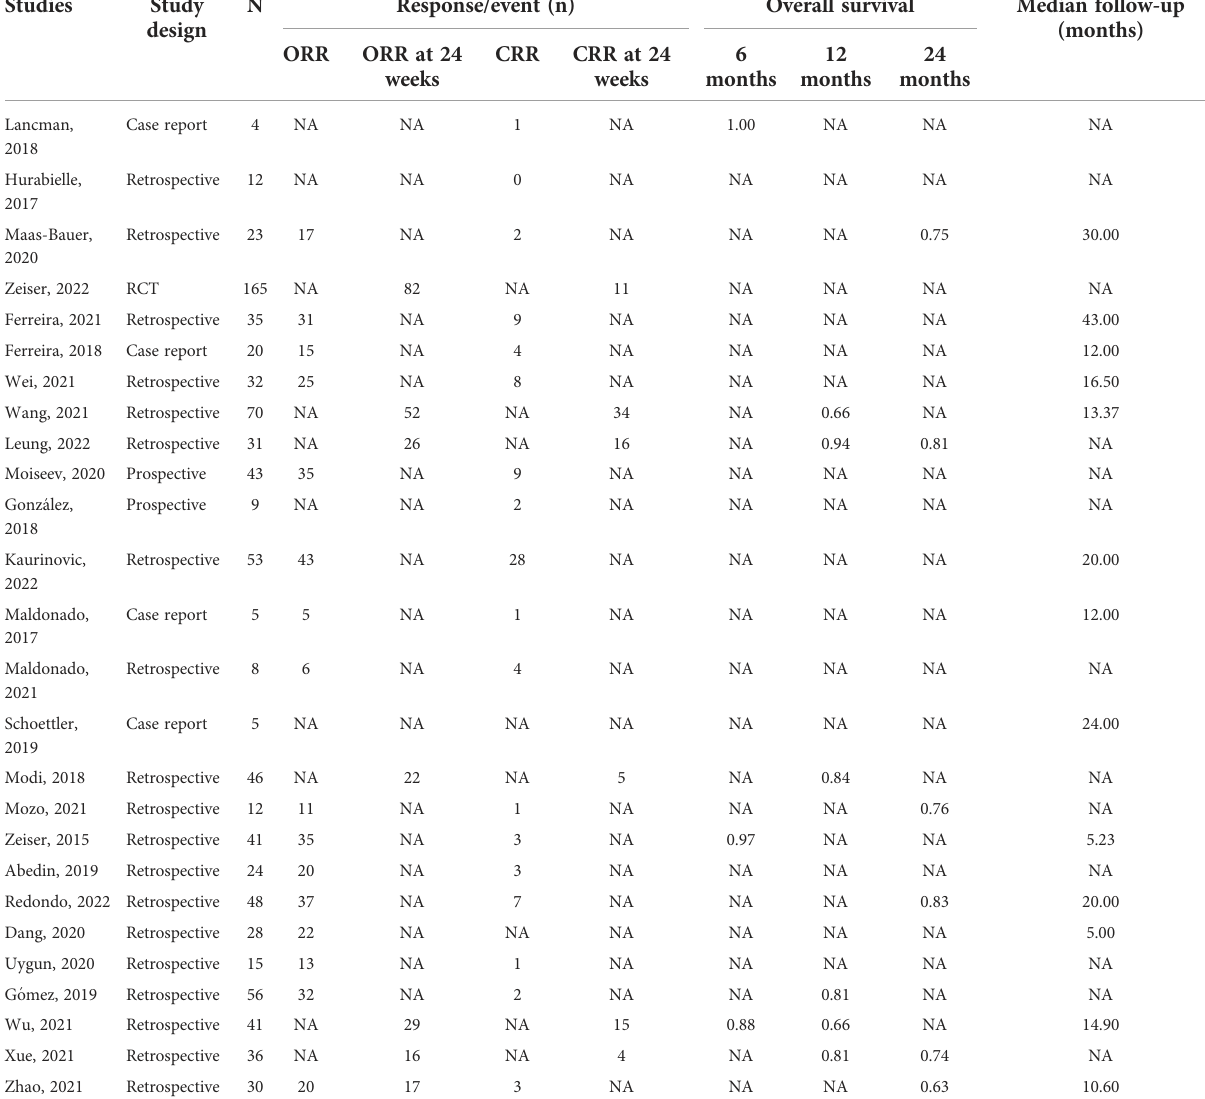
TABLE 4 Characteristics of therapeutic response for 26 included studies (SR-cGVHD) *